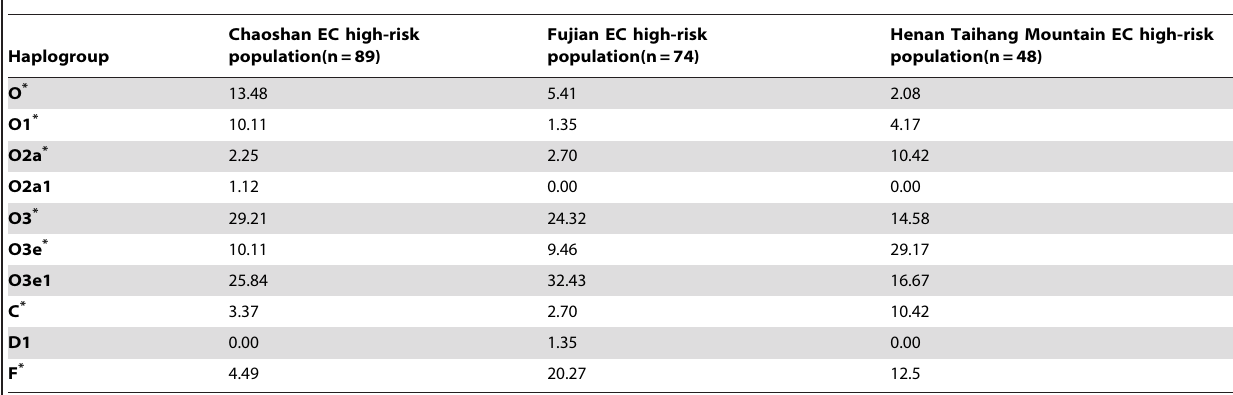
Table 1. Y-chromosome single nucleotide polymorphism (Y-SNP) haplogroup frequencies of the 3 EC high-risk populations (%).